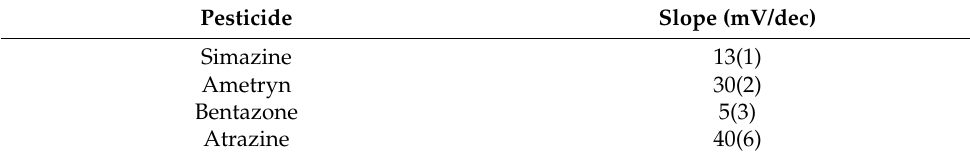
Table 2. Slopes of standardization curves (in HCl at pH 1.5) for the pesticides, analyzed as interferents: simazine, ametryn, and bentazone. For comparison, the slope of the standardization curve for atrazine is shown in the last row. Numbers in parenthesis are the standard deviations on the last digit.